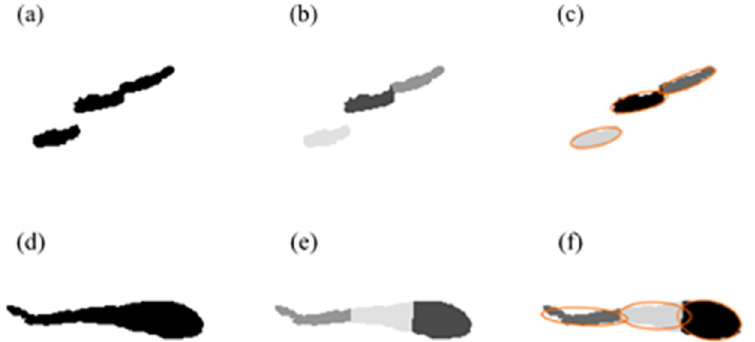
Fig 4. Steps used to calculate the shape of an echo of an eel (top) or non-eel fish (bottom) pass extracted from an ARIS camera image: (a, d) binary image, (b, e) segmentation using k-means clustering and (c, f) division of the fish body into three sections to calculate eccentricity.